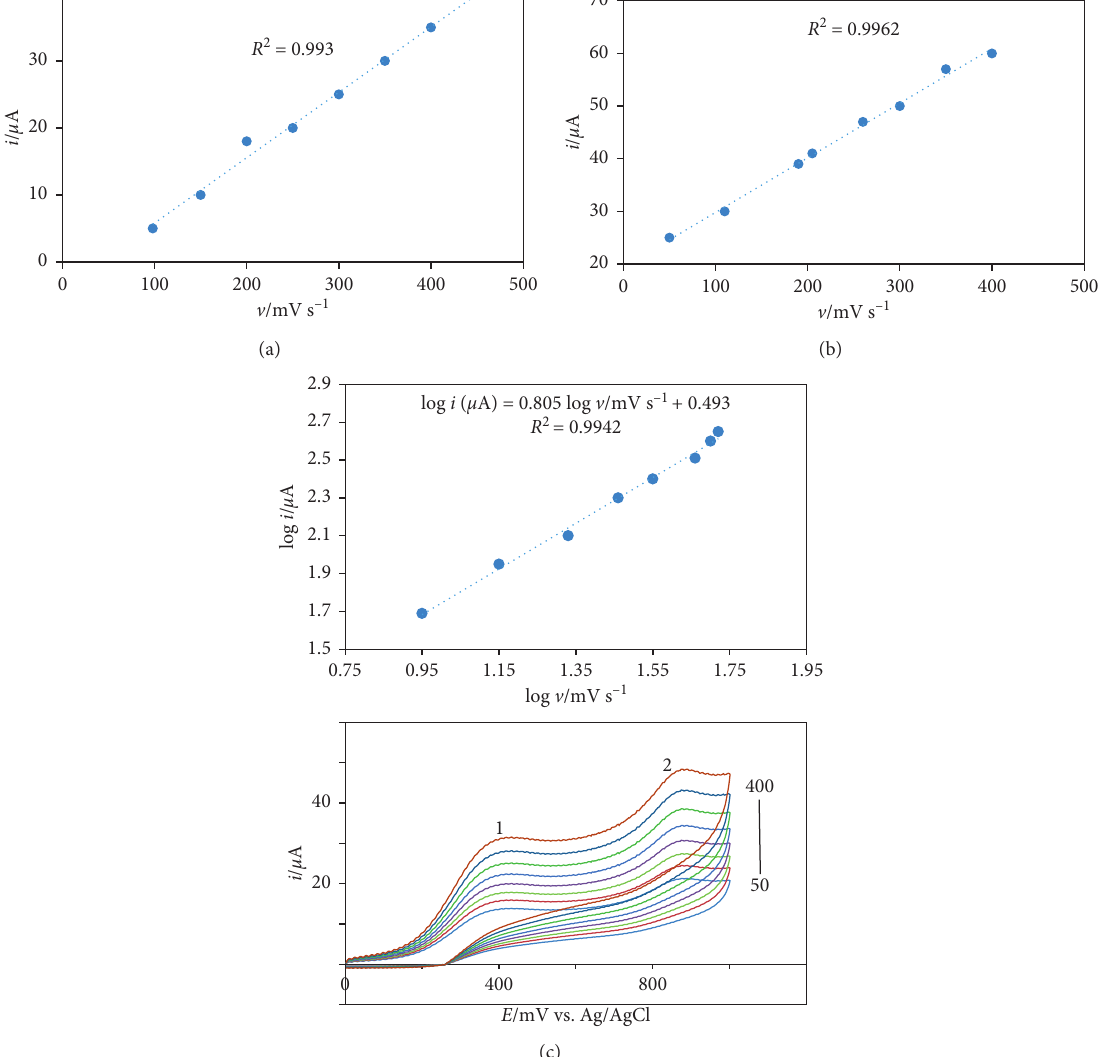
2 /GNR/GCE (d) at various scan rates